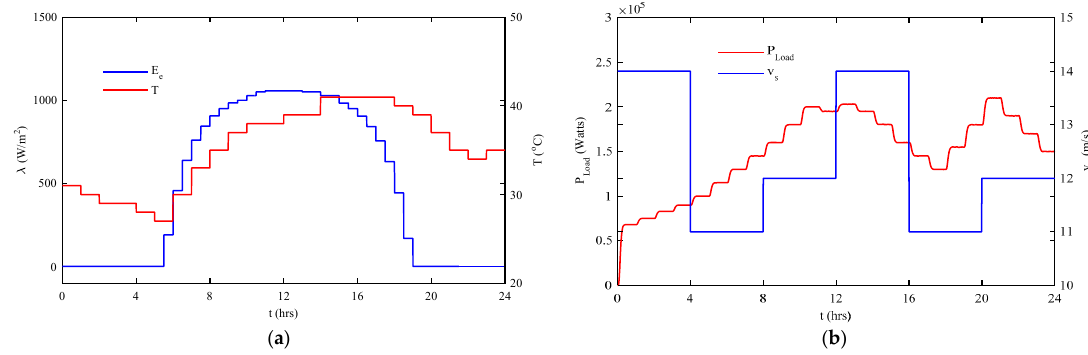
Figure 3. ( a ) Irradiance and ambient temperature levels; ( b ) wind speed and load for 22 June 2015.